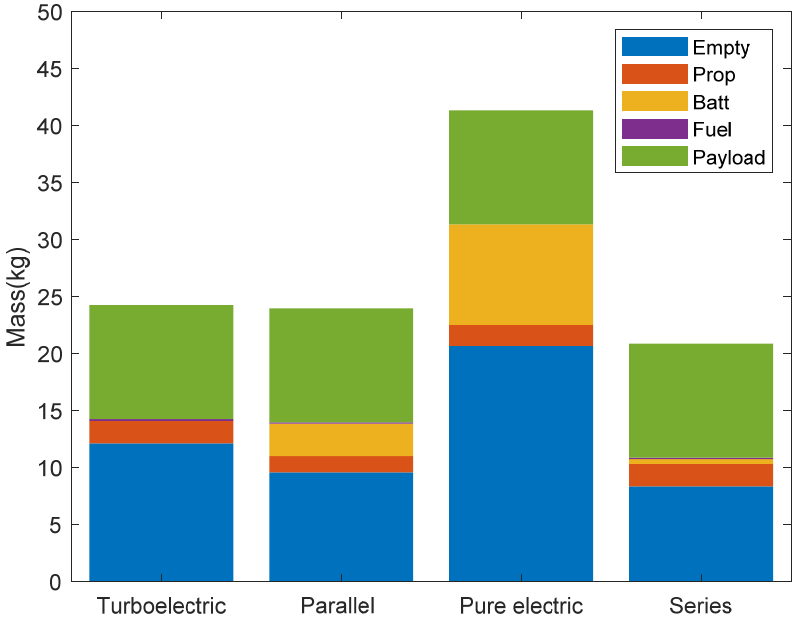
Figure 5. Case 1: MTOM and mass of other parts of UAVs.